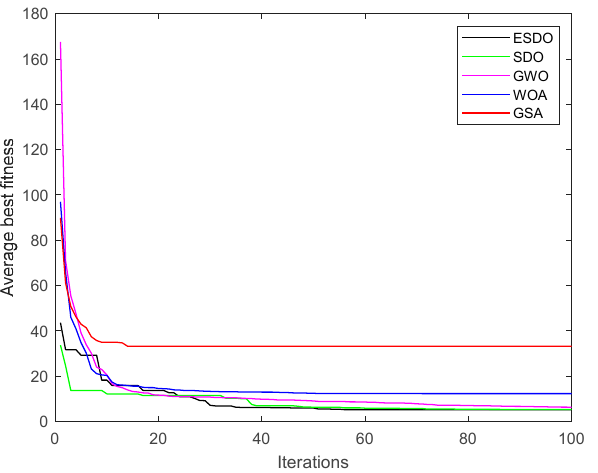
Figure 15. Convergence curves of average fitness with 12% load.